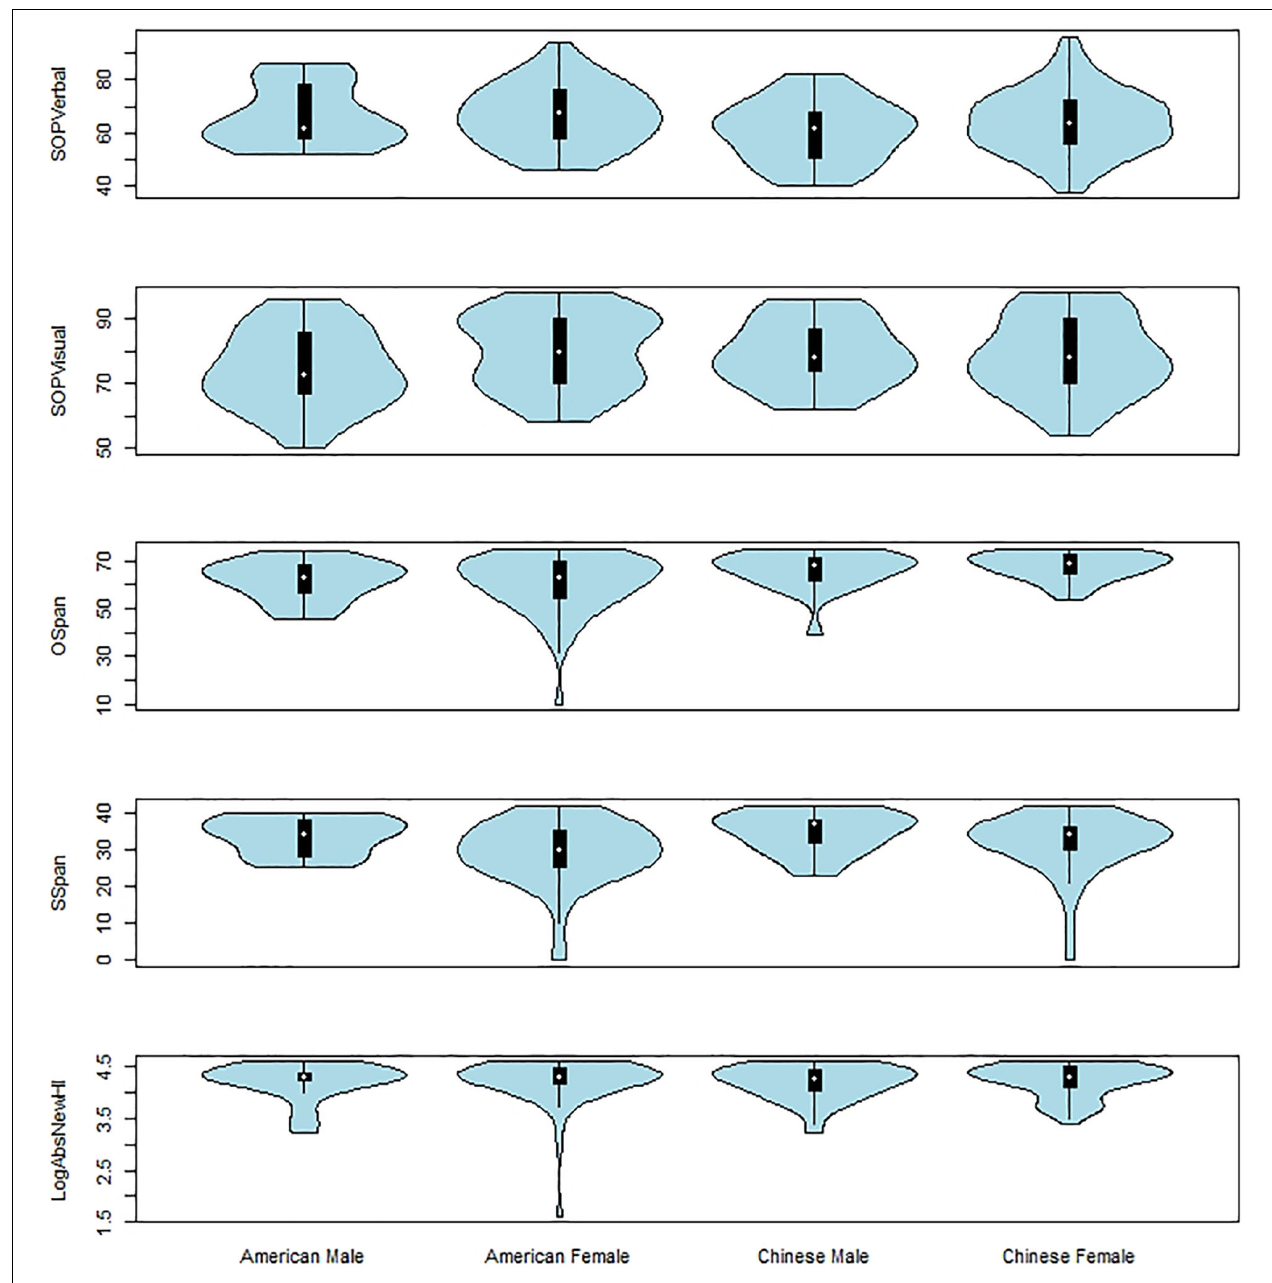
FIGURE 3 | Violin Plots of SOPVerbal, SOPVisual, OSpan, SSpan, and LogAbsNewHI as a Function of Group and